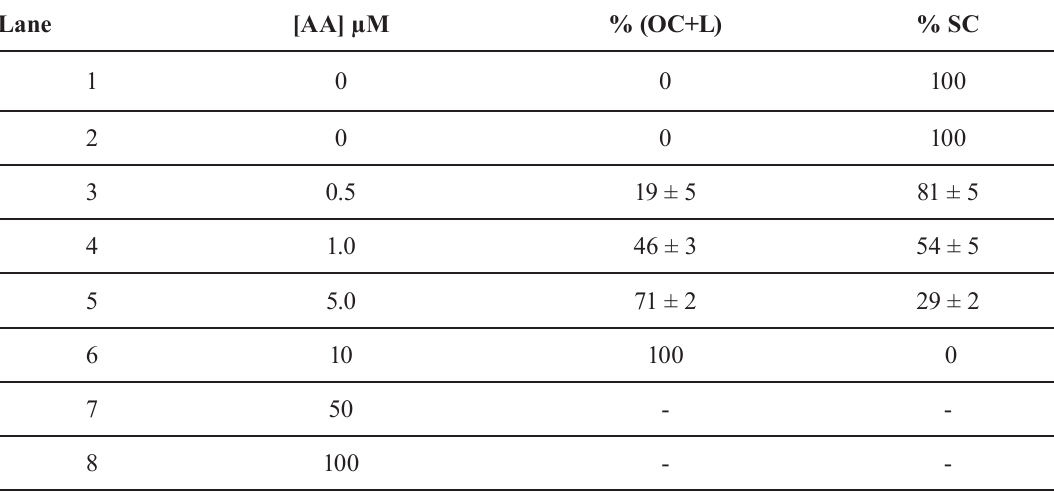
TABLE I – % of forms (OC + L) and SC of pUC-19 DNA (experimental conditions according to Figure 1 B)